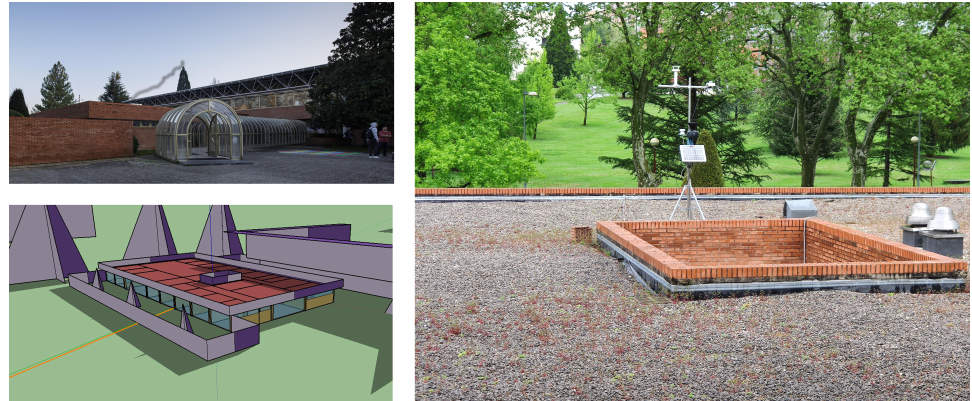
Figure 5. Building’s outdoor photograph ( top left ), simulation model image from OpenStudio [60] ( bottom left ), and the weather station located on the roof of the building ( right